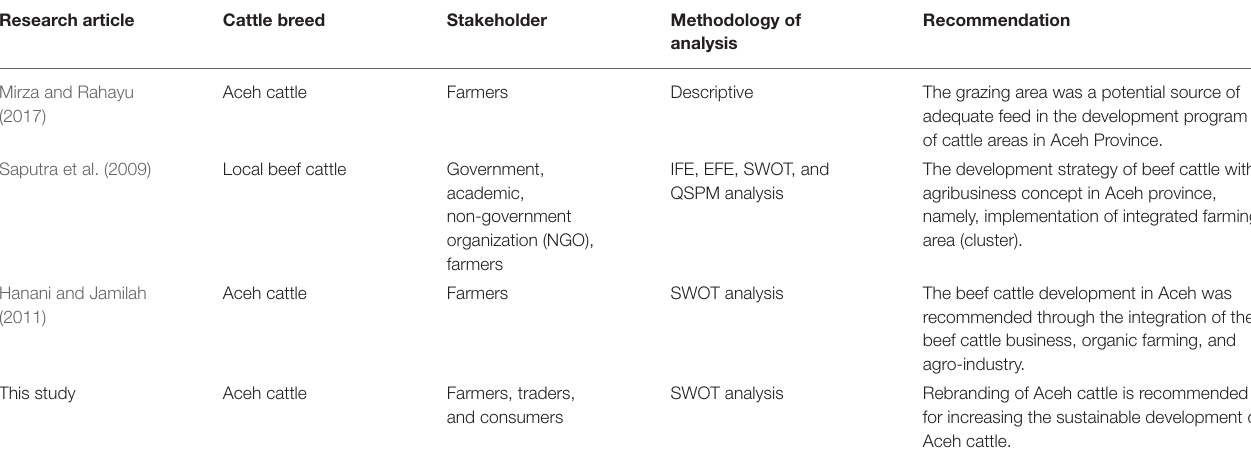
TABLE 3 | Summary of the research related to local beef cattle development in Aceh Province, Indonesia.